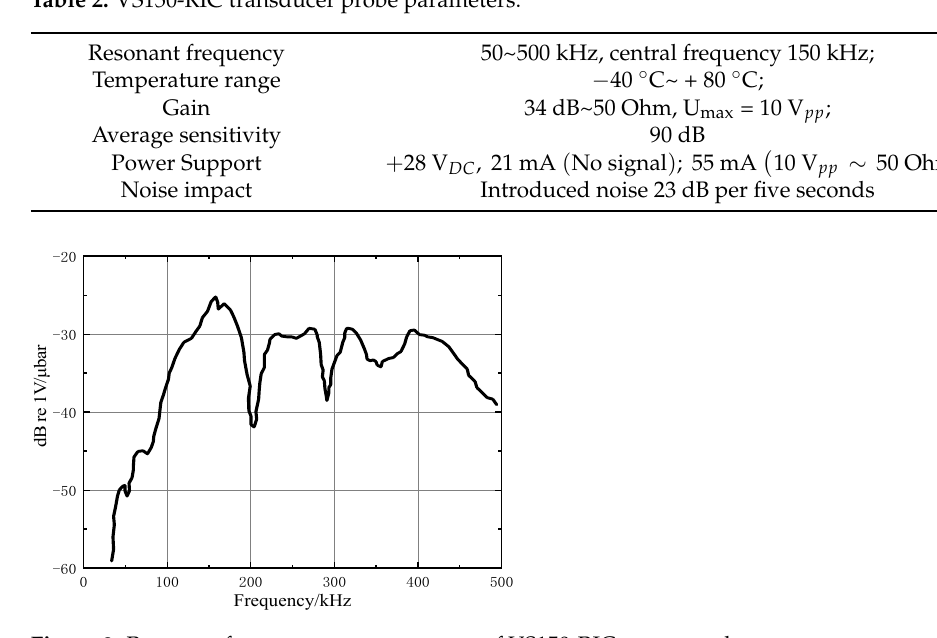
Table 2. VS150-RIC transducer probe parameters.